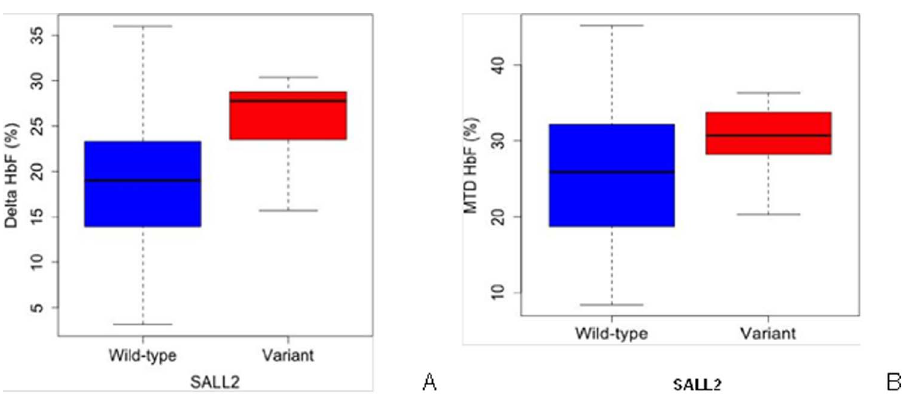
Figure 2. Effect of SALL2 variant rs61743453 on HbF response to hydroxyurea. A, Effect of rs61743453 on delta HbF in discovery cohort. B, Effect of rs61743453 on MTD HbF in validation cohort. Variant refers to the Pro840Arg variant; no individuals were homozygous for this change.